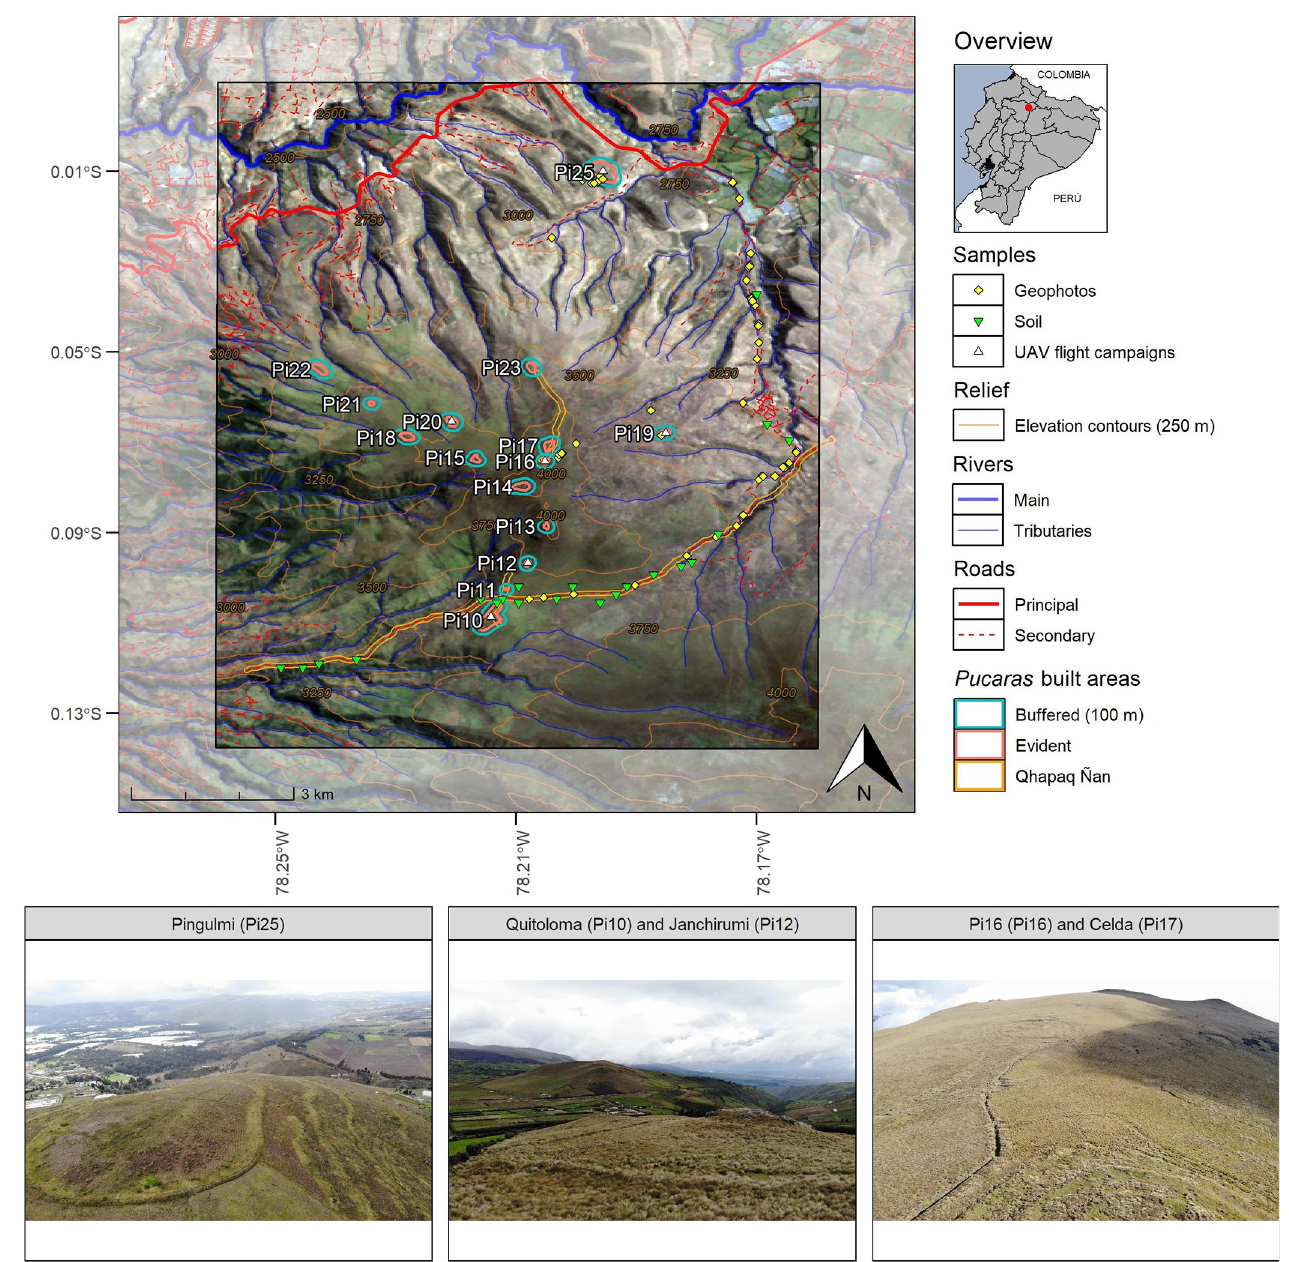
Fig 1. Study area where the Pambamarca volcano and its Pucaras are located (background image corresponds to Landsat composite 1986–2000). Bottom: UAV photos provide a visual impression of the Pucaras . Map data sources provided by IGM [27].